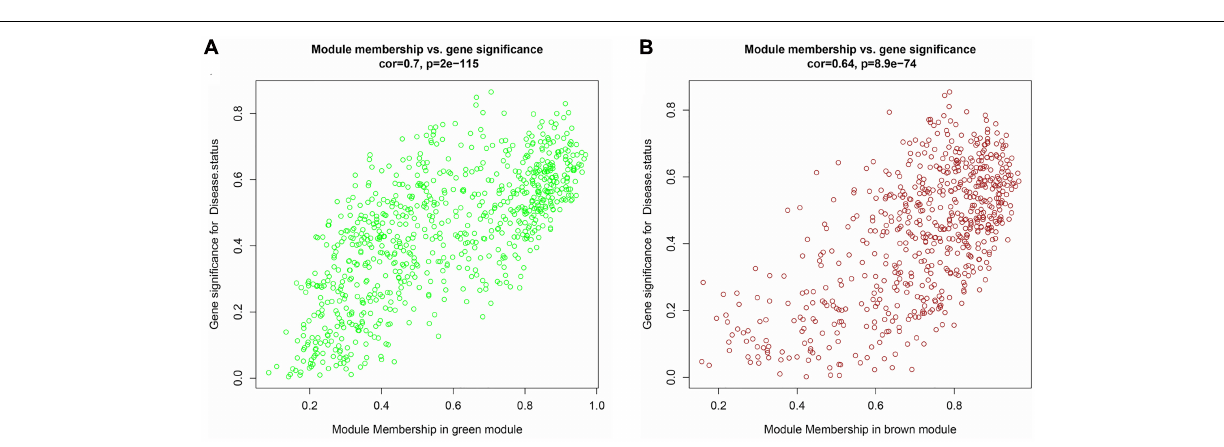
FIGURE 3 | Scatter plot of module membership (MM) vs. gene significance (GS) in (A) green and (B) brown modules. MM presents the correlation between gene expression and each module eigengene. GS represents the association between gene expression and each trait. In both modules, GS and MM have a high